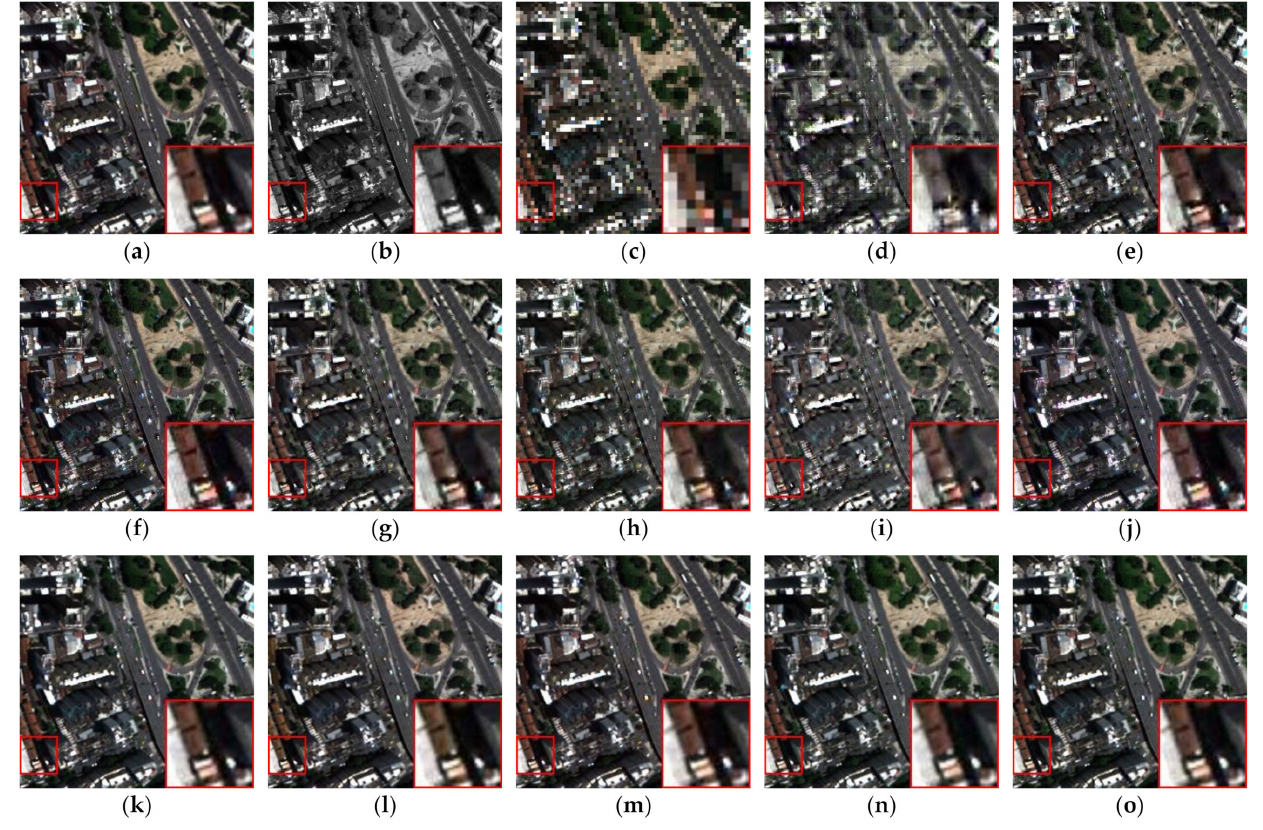
Figure 13. Results for four bands using the WorldView-3 dataset (resolution, 256 × 256 pixels): ( a ) reference image; ( b ) PAN; ( c ) LRMS; ( d ) DWT; ( e ) HPF; ( f ) GS; ( g ) GLP; ( h ) SFIM; ( i ) IND; ( j ) PRACS; ( k ) DMDNet; ( l ) CPNet; ( m ) TPNwFB; ( n ) TDPNet; ( o ) ours